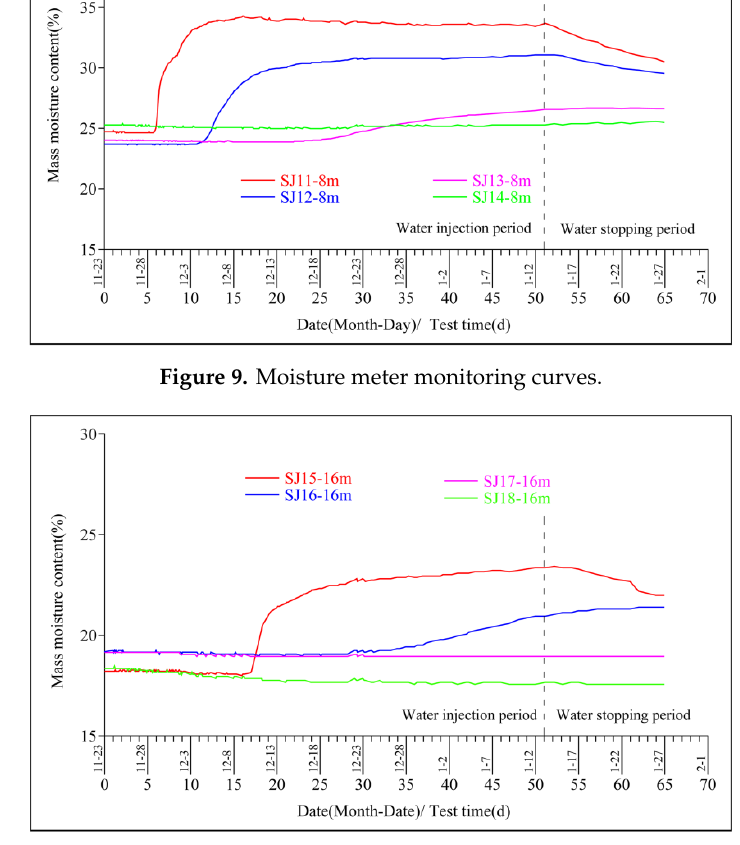
Figure 10. Moisture meter monitoring curves.